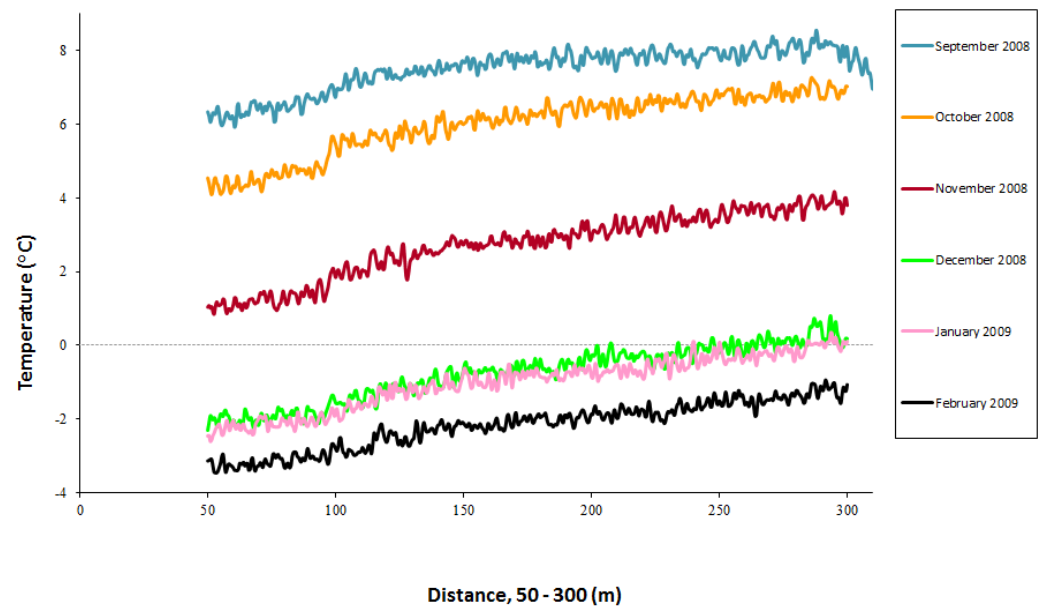
Figure 2. Seabed sediment temperatures measured from September 2008 to February 2009 in Liito-oravankatu (data from [22]).